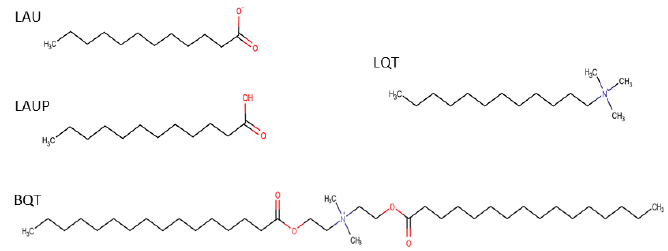
Figure 1. Chemical structures for the 4 molecules studied: laurate (LAU), lauric acid (LAUP), C16-